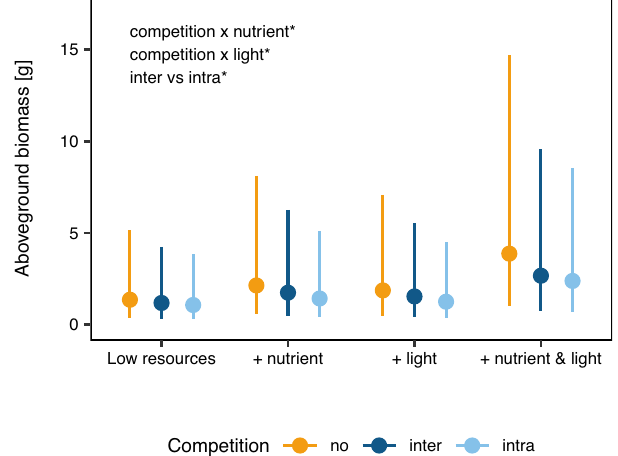
Fig. 3 Effects of nutrient and light availabilities on effects of intra- and interspeci fi c competition on plant aboveground biomass. Yellow, dark blue, and light blue colors represent plants without competition, and with inter- and intraspeci fi c competition, respectively. Error bars indicate 95% CIs. The effect of nutrient and light availabilities on intra- and interspeci fi c competition did not signi fi cantly depend on the origin of the plants (see Supplementary Note 1 for details). Signi fi cant effects are indicated in the left upper corner (see Supplementary Table 2 for